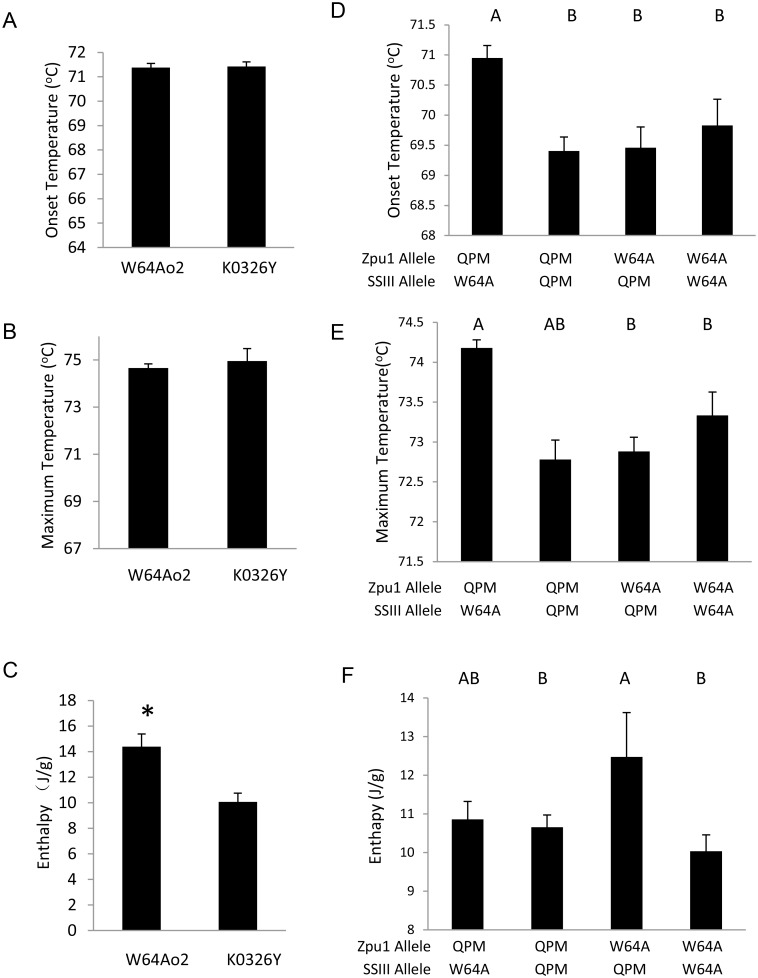
Thermal properties of starch.(A-C) Comparison of starch thermal properties, including onset temperature, maximum temperature and enthalpy, between W64Ao2 and K0326Y. Significant level indicated by asterisks at p<0.05 by two-tailed t test (D-F) Comparison of the starch thermal properties among RILs. For parental lines, each column represents mean thermal property values of three independent ears of corresponding lines; and for RILs, each column represents mean thermal property values of all RILs of the corresponding genotype with three independent ears for each individual RIL. The letters above each column represent statistically significant differences among the lines for p<0.05 by pairwise two-tailed t-test. Columns sharing the same letter are not significantly different from one another. The error bars represent standard error.